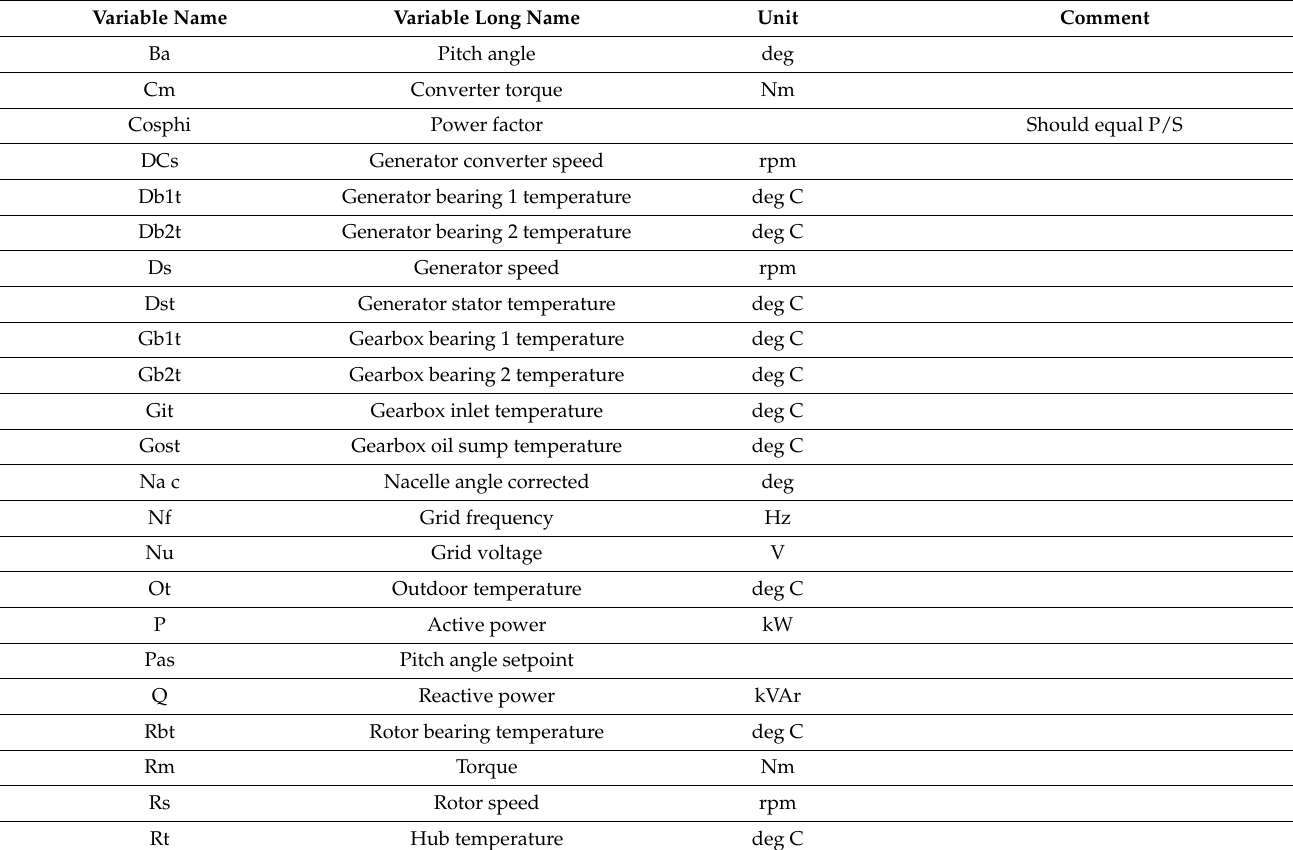
Table 4. Description of WT operation variables